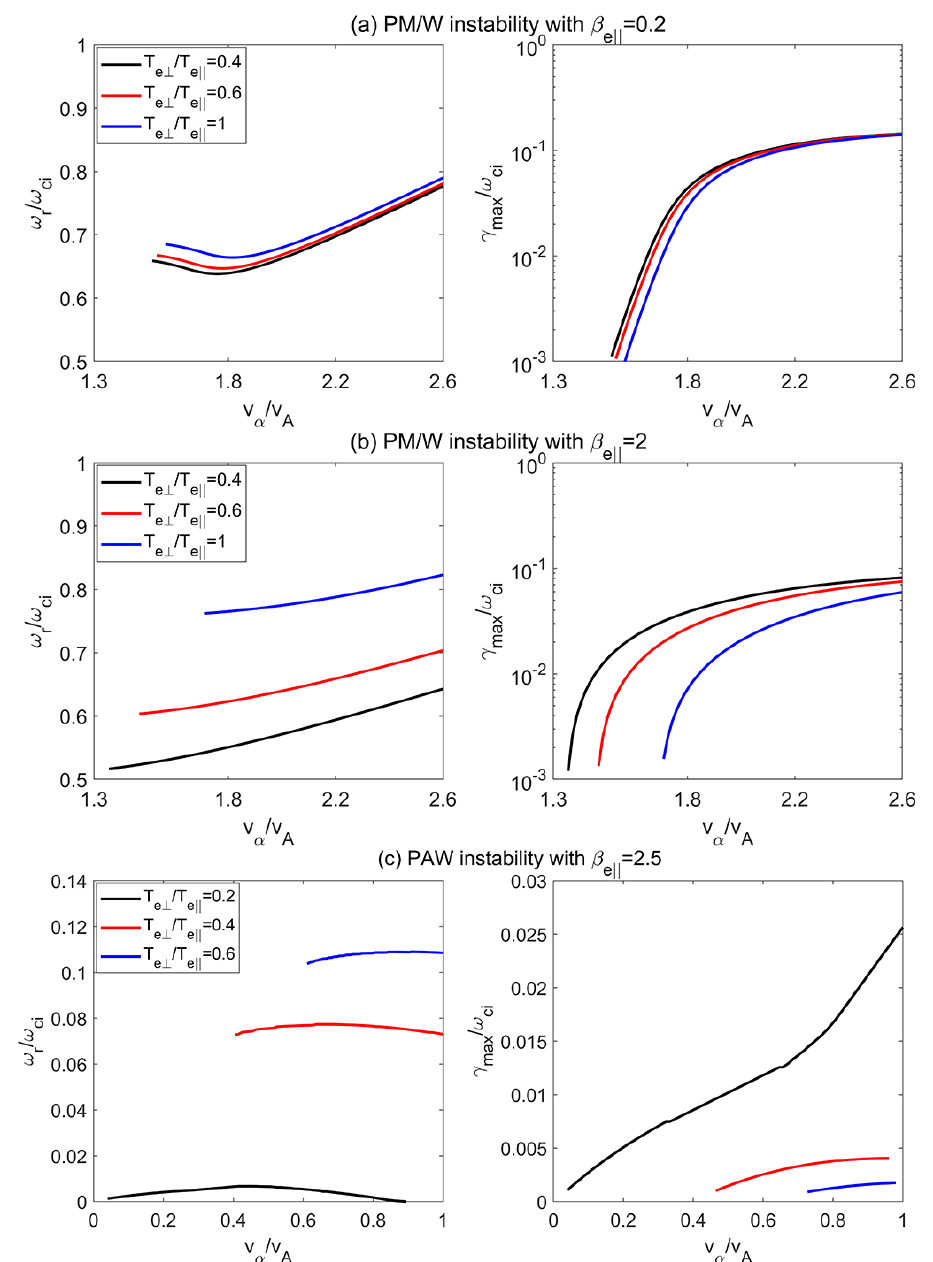
Figure 4. The real frequency ( ω r / ω ci ) and maximum growth rate ( γ max / ω ci ) versus the alpha beam drift velocity ( v α / v A ) for ( a ) the PM/W instability with β e (cid:107) = 0.2, ( b ) the PM/W instability with β e (cid:107) = 2, and ( c ) the PAW instability with β e (cid:107) = 2.5. In ( a , b ), the black, red, and blue lines represent electron temperature anisotropies at T e ⊥ / T e (cid:107) = 0.4, 0.6, and 1, and in ( c ), these lines represent T e ⊥ / T e (cid:107) = 0.2, 0.4, and 0.6,